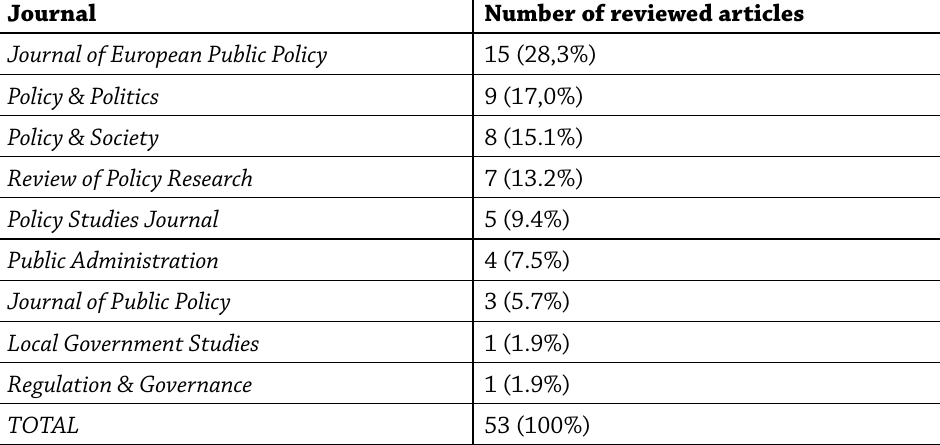
Table 1: Distribution of reviewed articles per journal